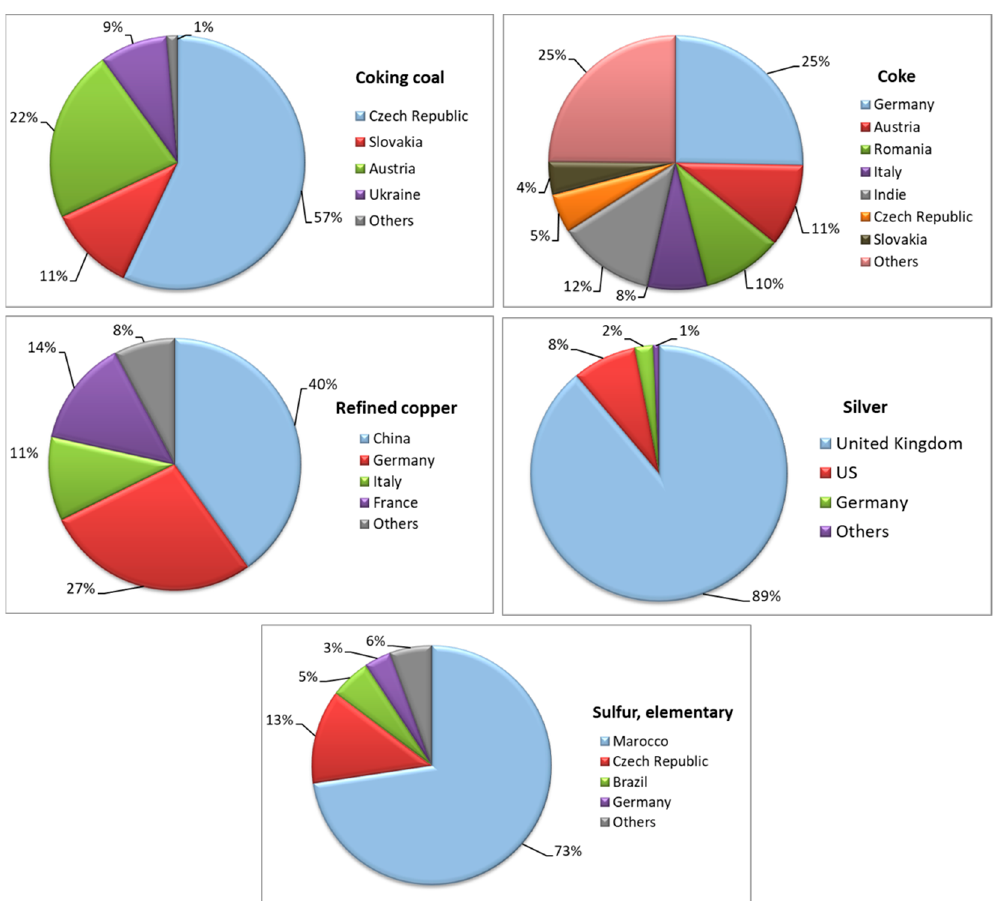
Figure 2. Export structure of analyzed mineral raw materials in 2018 (based on